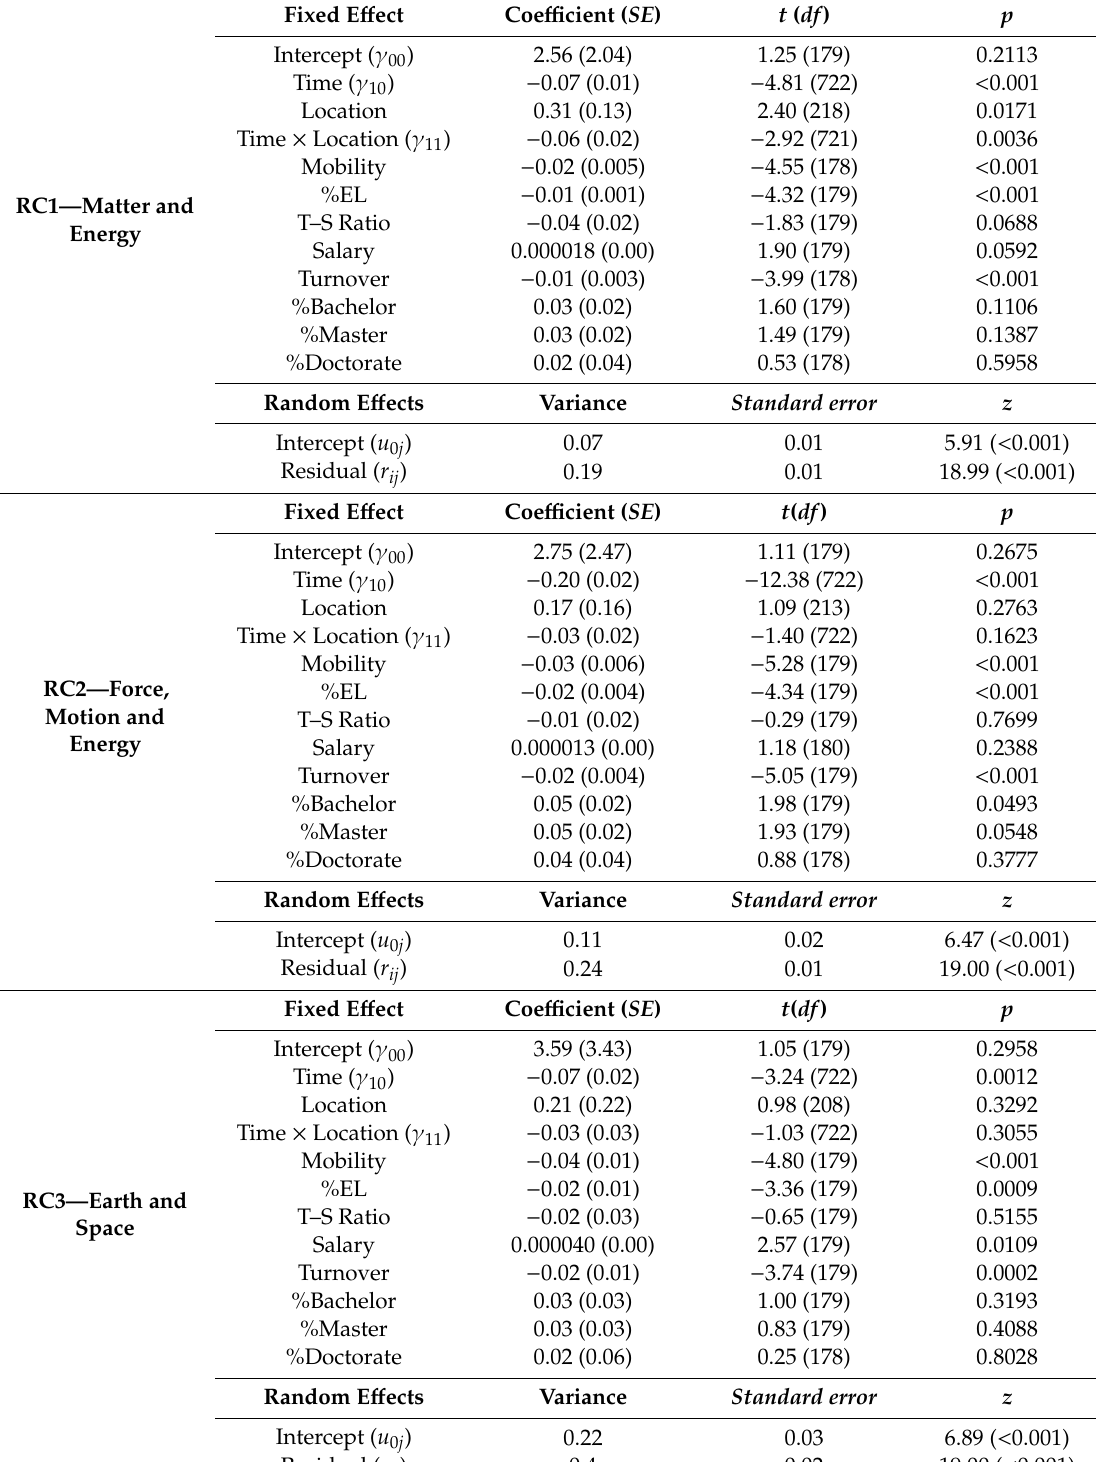
Table 7. Parameter estimates of fixed and random e ff ects of Model 5 by reporting